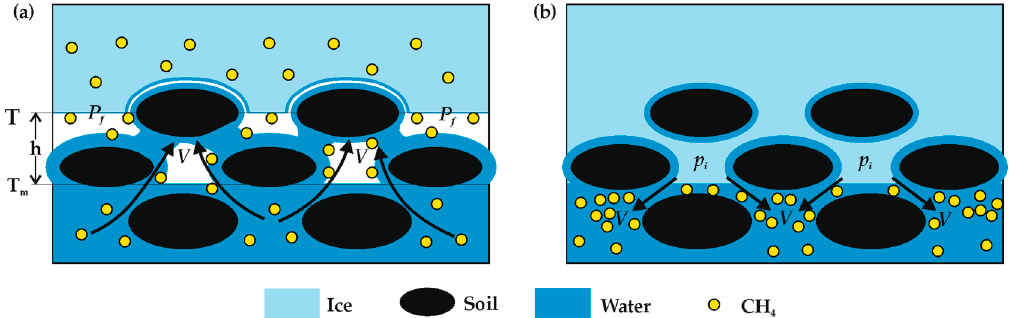
Figure 5. Schematic representation of the water and methane flows in freezing soils. ( a ) Cryogenic suction case; ( b ) Ice penetration to pores with squeezing of the excess water and methane.